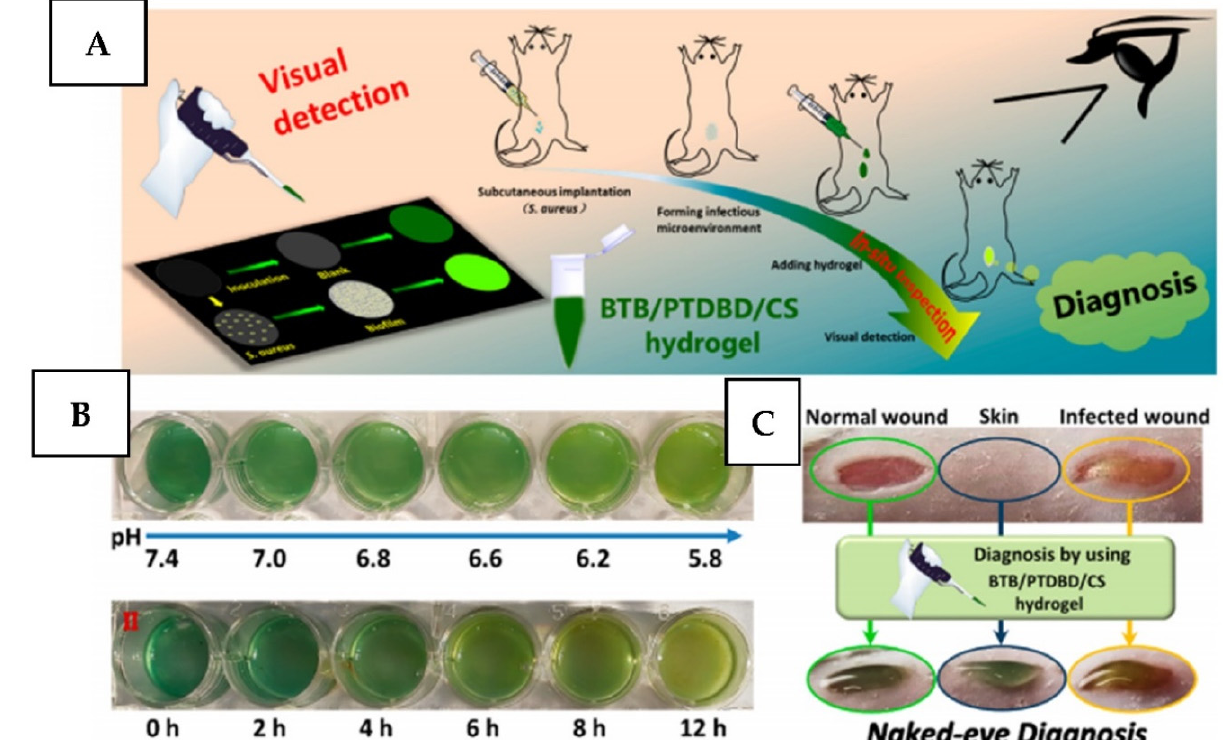
Figure 21. ( A ) A schematic illustration of visual detection of a bacterial biofilm and diagnosis of bacterial infection of mice by using bromothymol blue/(NIR)-absorbing conjugated polymer/chitosan (BTB/PTDBD/CS) hydrogel. ( B ) Detection of different pH (I) and growth of bacteria (II) by using the BTB/PTDBD/CS hydrogel. ( C ) Photographs of diagnosis of bacteria-infected wounds of mice. Reprinted with permission from ref. [222]. Copyright 2020 American Chemical Society.